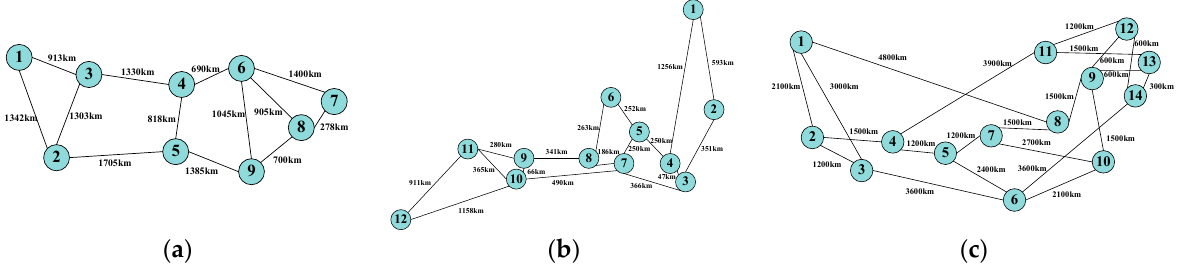
Figure 4. ( a ) Simple mesh network topology; ( b ) Japan network topology; ( c ) NSF network topol- ogy. Table 4. Characteristics of the simulated network topology.